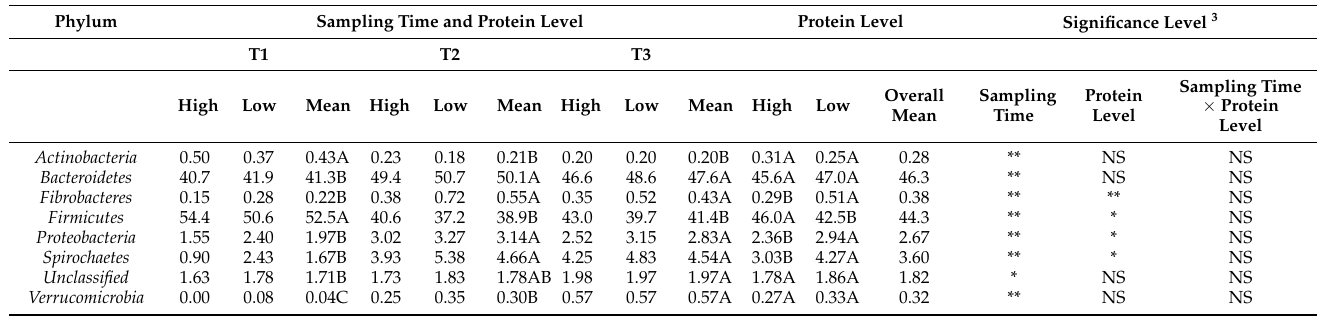
Figure 2. Principal coordinate analysis of the piglet fecal microbiota. Red dots: high protein level, blue dots: low protein level. Contour lines highlight the 3 sampling times, T1, T2, and T3, from left to right. Table 7. Relative abundance of bacterial phyla in the piglet fecal microbiota depending on sampling time and protein level 1,2